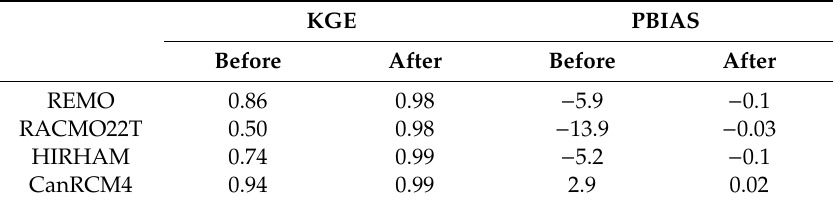
Table 7. E ffi ciency of temperature bias Table 7. Efficiency of temperature bias correction.